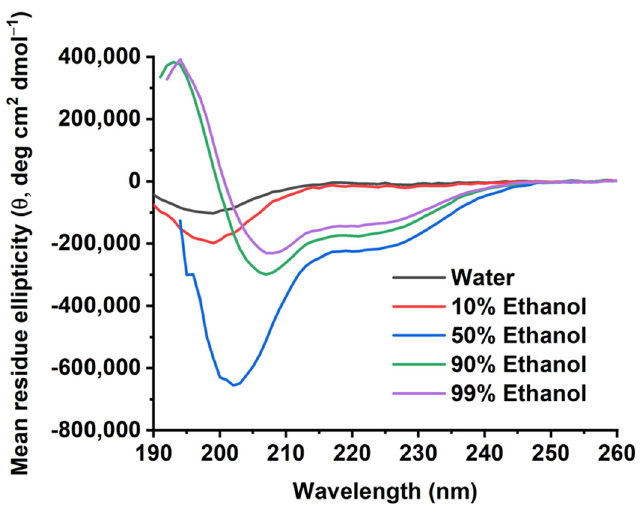
Figure 1. CD of 0.1 mM GL13K in water or ethanol solutions with ethanol volume fractions of 10%, 50%, 90%, and 99%. Table 1. Fractions of secondary structures of GL13K in ethanol solutions estimated by CDPro.